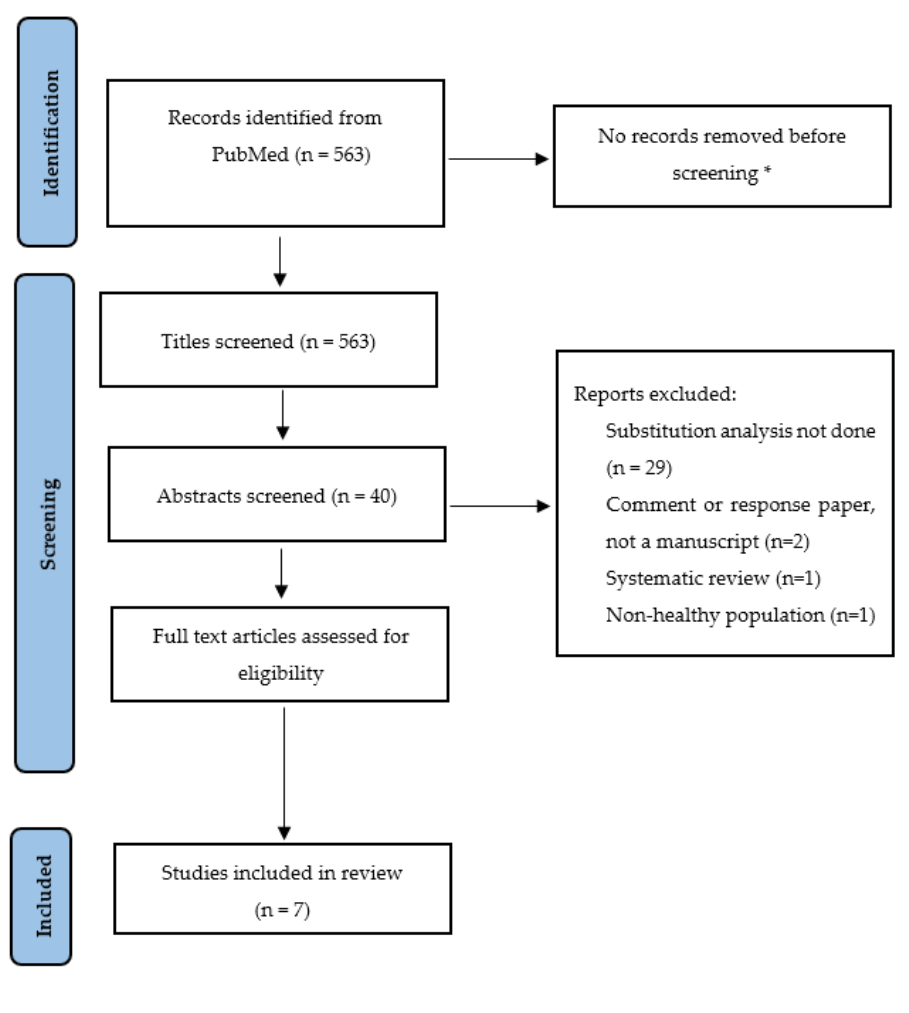
Figure 1. PRISMA flow diagram showing search strategy and selection process.